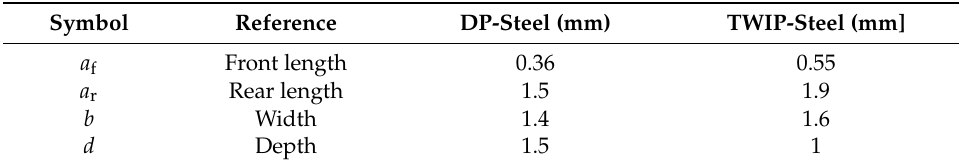
Table 8. Parameters calibration of double-ellipsoidal heat source for electric arc: DP and TWIP steel (see Figure